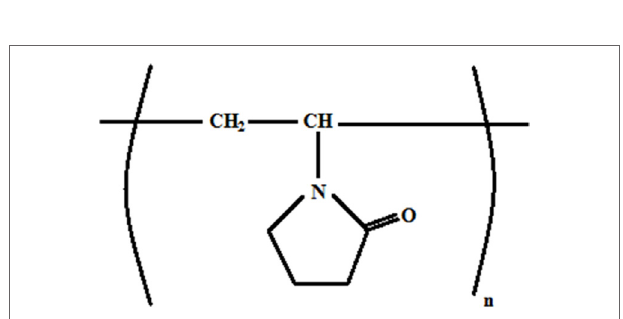
FigUre 1 | schematic of the processing steps involved in getting the calcined nanofibers of titania